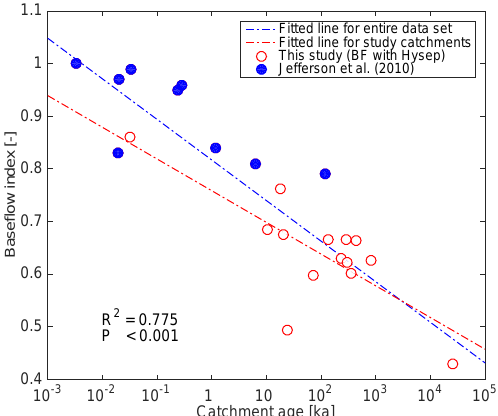
Figure 13. Baseflow index with catchment age. Dashed line is re- gressed line for the study catchments ( R = − 0 . 756, p = 0 . 0017). Dotted line is regressed line for the integrated data set of the catch- ments in Japan and the Oregon Cascades from Jefferson et al. (2010) ( R = − 0 . 879, p < 0 .